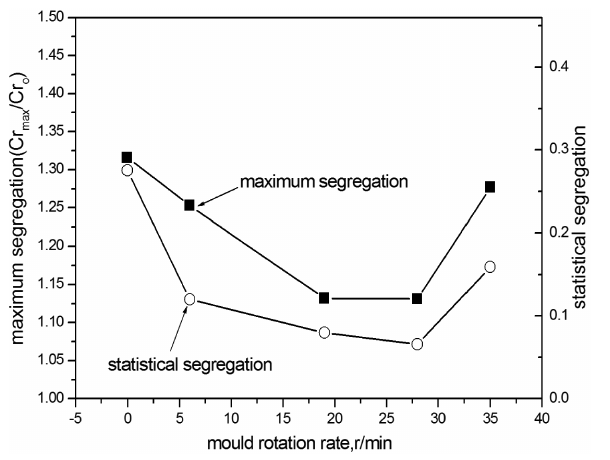
Fig. 6: Relation between chromium segregation and mould rotation